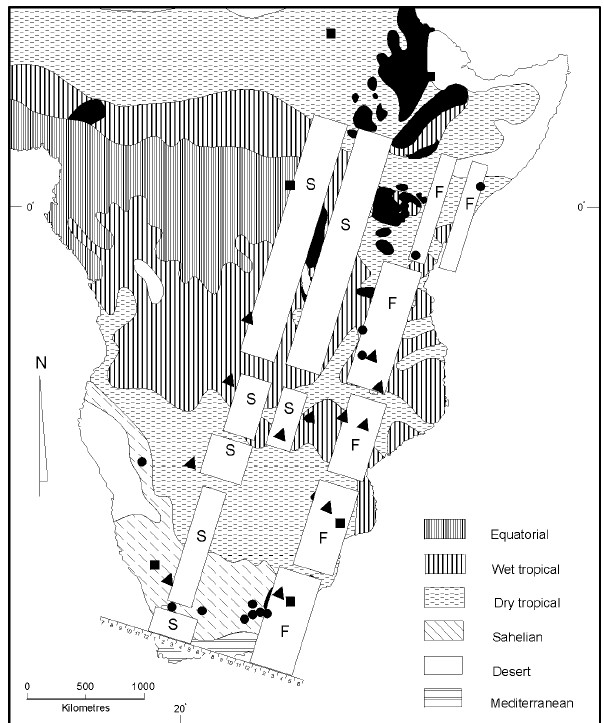
Figure 5 - Map of regions of high morphometric variance in relation to the major zones of vegetation (biomes) in eastern Africa. High variance do- mains are primarily associated with transitional areas between biomes. Symbols as in Figure 3. (Map modified from van Chi-Bonnardel,